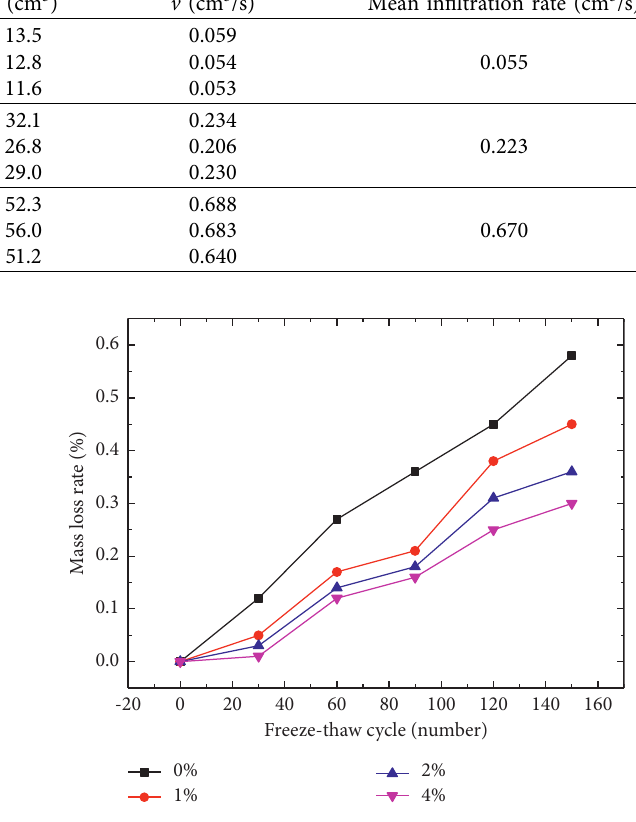
Figure 5: Mass loss rate in the freeze-thaw test.